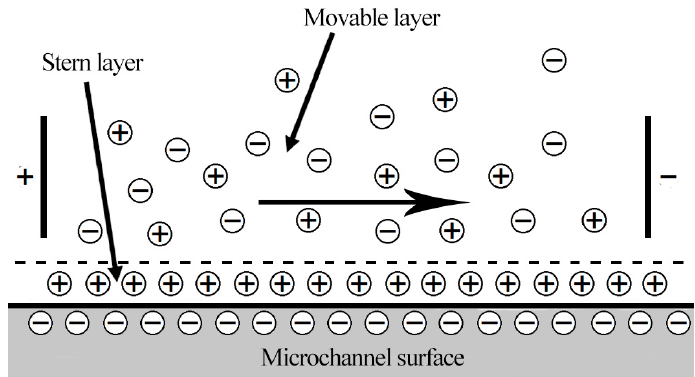
Figure 3. Schematic of electric double layer.